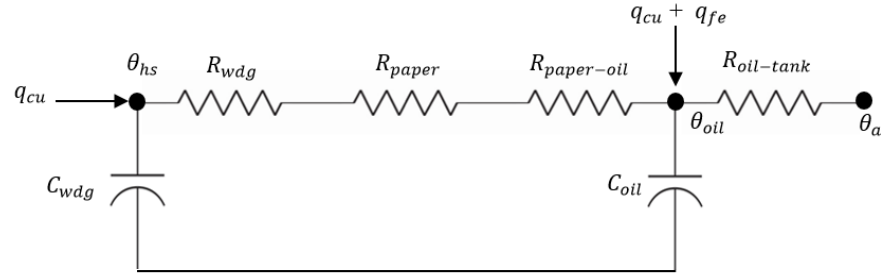
Figure 5. Thermal resistance equivalent circuit with lumped capacitance.